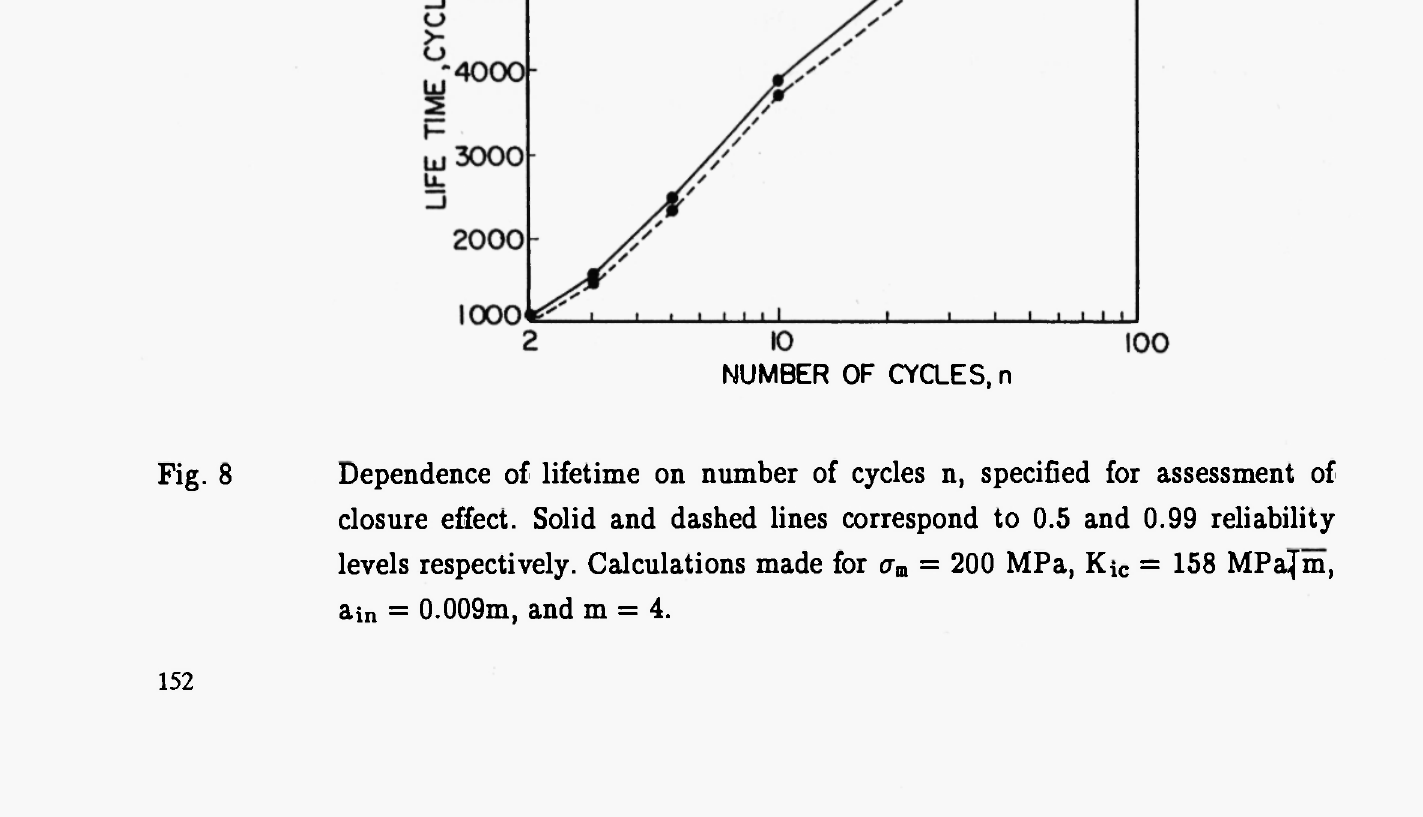
Fig. 7 Dependence of lifetime on · maximum stress characterizing cyclic stress distribution for m = 4. Solid and dashed liens correspond to 0.5 and 0.99 reliability levels respectively. Calculation made for Kj a = 0.009m„ and η = 10. in